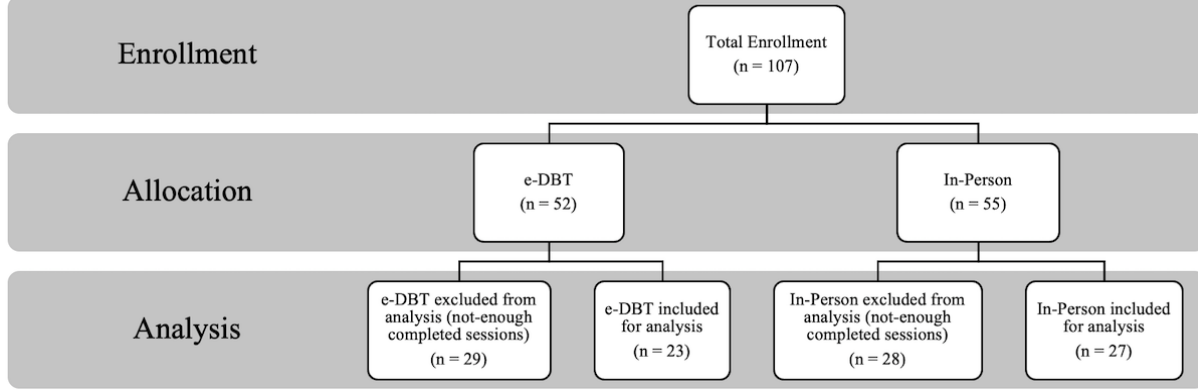
JMIR Ment Health 2021 | vol. 8 | iss. 4 | e27308 | p. 4https://mental.jmir.org/2021/4/e27308 (page number not for citation